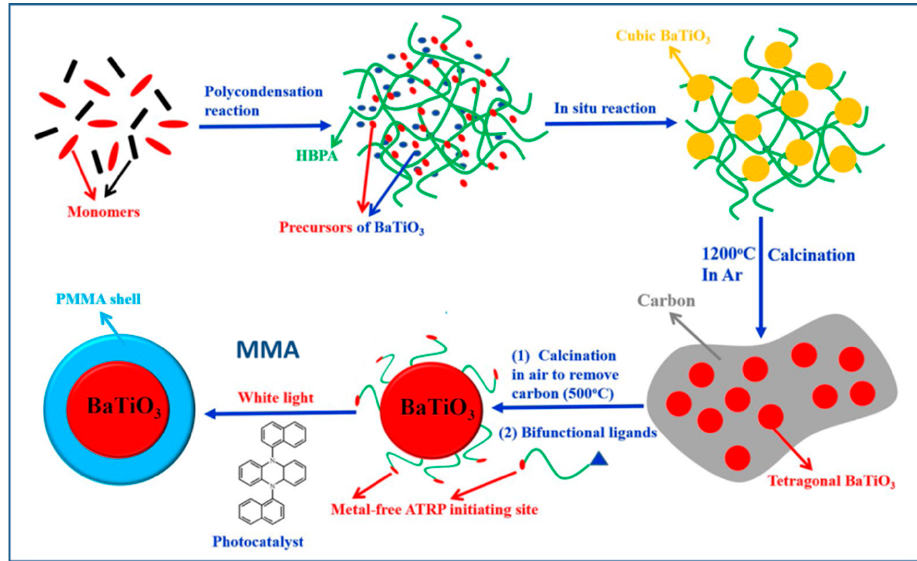
Figure 6. Scheme for the preparation of core/shell ferroelectric BaTiO 3 /PMMA hybrid nanoparticles by metal-free ATRP process driven by visible light based on novel hyperbranched aromatic polyamides (HBPA) as functional matrix. Reproduced with permission from Ref [120].